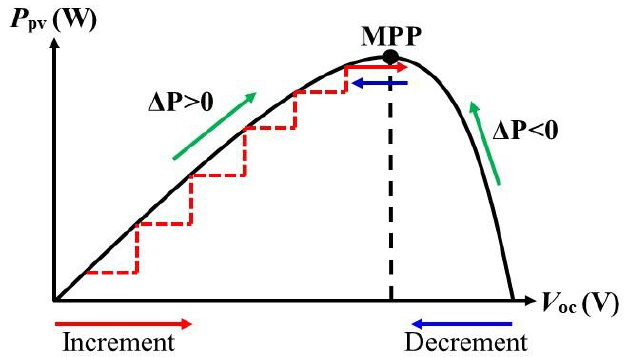
Figure 3. Control strategy of the conventional P&O algorithm.